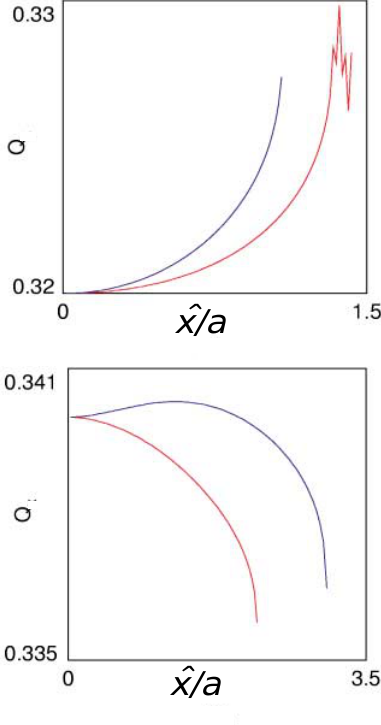
FIG. 8. (Color) Nonlinear tune Q (cid:1) V (cid:1) 2 p for a pure sextu- pole (red line) and a sextupole 1 space charge (blue line). (Top) v 0 (cid:1) 0.32 3 2 p , a ˆ K 0 2 (cid:1) 0.3 , ˆ j (cid:1) 0.05 . (Bottom) v 0 (cid:1) 0.34 3 2 p , a ˆ K 0 2 (cid:1) 0.14 , ˆ j (cid:1) 0.05 . The horizontal coordinate